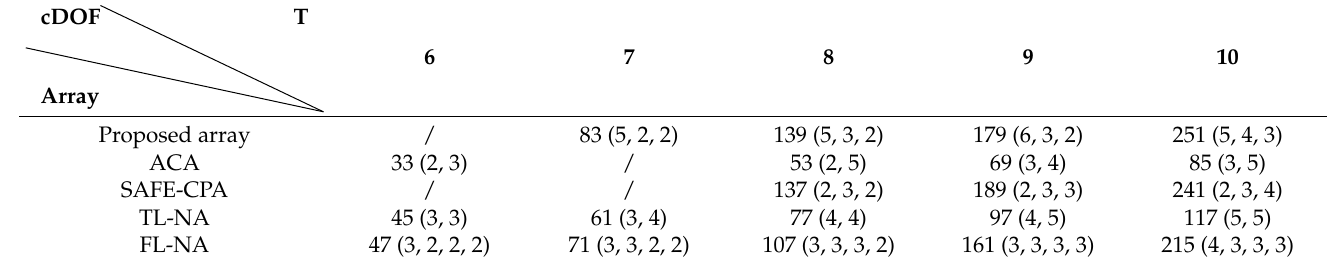
Table 4. cDOF examples of different array structures ( T = 6, · · ·